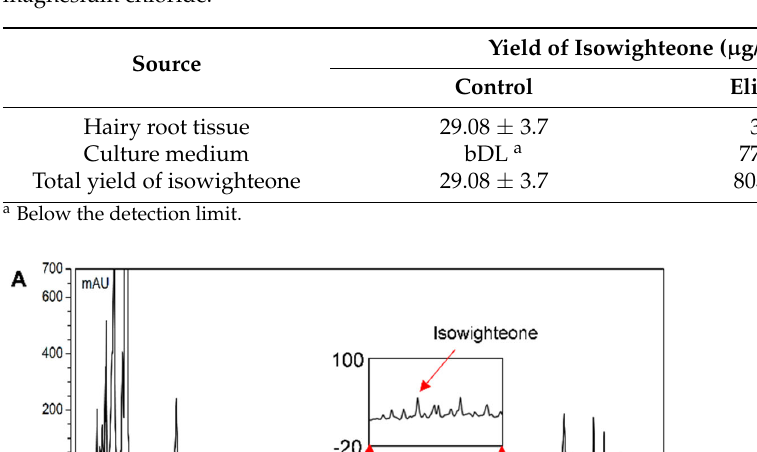
Table 2. Yield of isowighteone in the hairy root culture of pigeon pea (line G4). Twelve-day-old cultures were co-treated with methyl jasmonate, methyl- β -cyclodextrin, hydrogen peroxide, and magnesium chloride.